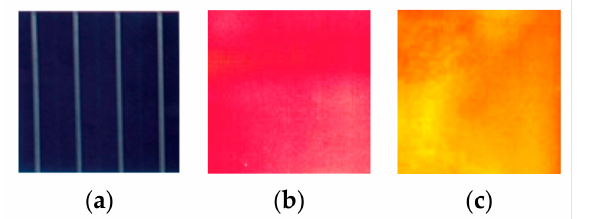
Figure 14. ( a ) Solar cell in ordinary image, from panel 1; ( b ) non-defective thermal solar cell image, from panel 1 (Sample 1); ( c ) thermal solar cell with series crack, from panel 2 (Sample 2). As shown in Figure 15, the three histogram results of the image from the ordinary camera show a non-bimodal scenario compared with the thermal camera on the panel. The histogram of the non-defective image (thermal image—panel 1) indicates both the histogram equalization and AHE exhibit a better-distributed pixel intensity value than the defective thermal image (panel 2).